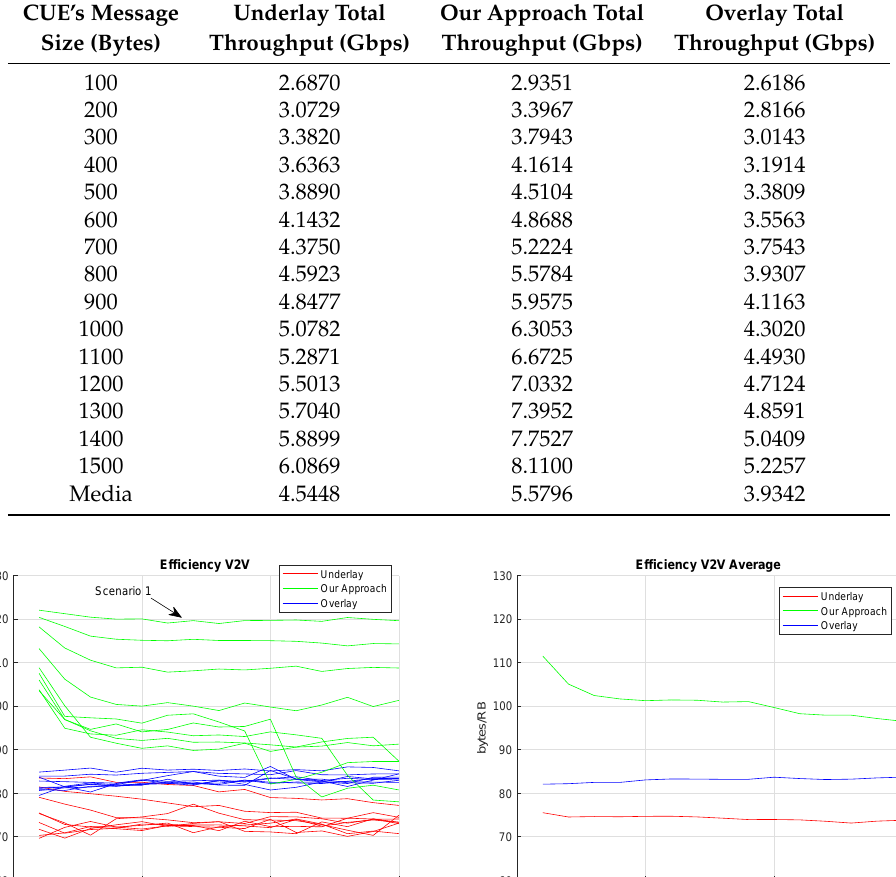
Table 4. Average Total Throughput achieved based on C-UEs’ traffic pattern.